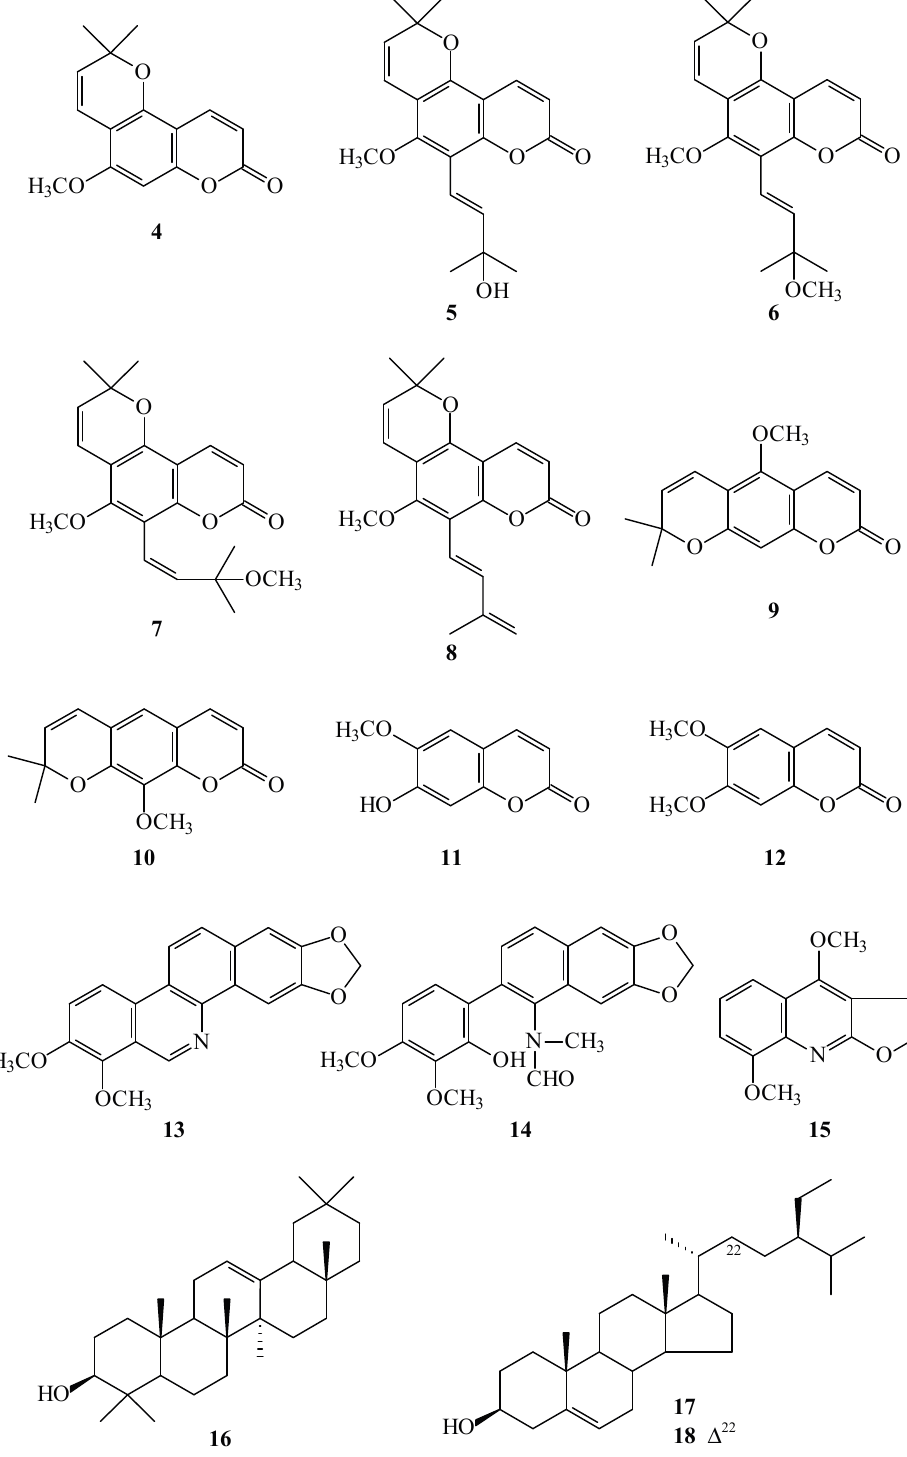
Figure 2. The chemical structures of known compounds 4 – 18 isolated from Z. avicennae